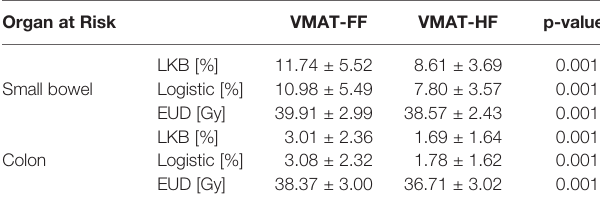
TABLE 5 | Comparison of normal tissue complication probabilities (NTCP) using Lyman – Kutcher – Burman (LKB) and logistic models and equivalent uniform dose (EUD) with statistical analysis using Wilcoxon signed-rank test in volumetric modulated arc therapy (VMAT)